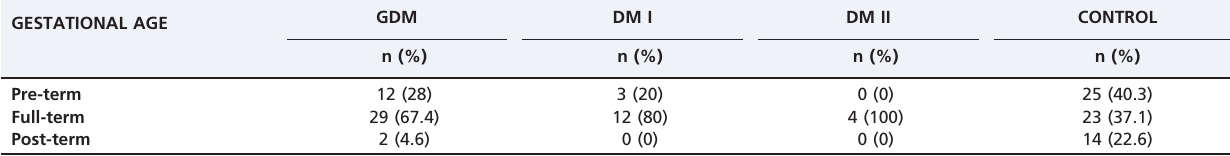
Placental changes in diabetes mellitus Salge AK et Table 4 - Distribution of gestational age for 62 women with or without (control of) diabetes mellitus, according to diabetes type, from Goiaˆnia, Central-West Brazil, between August 2009 and July 2010.